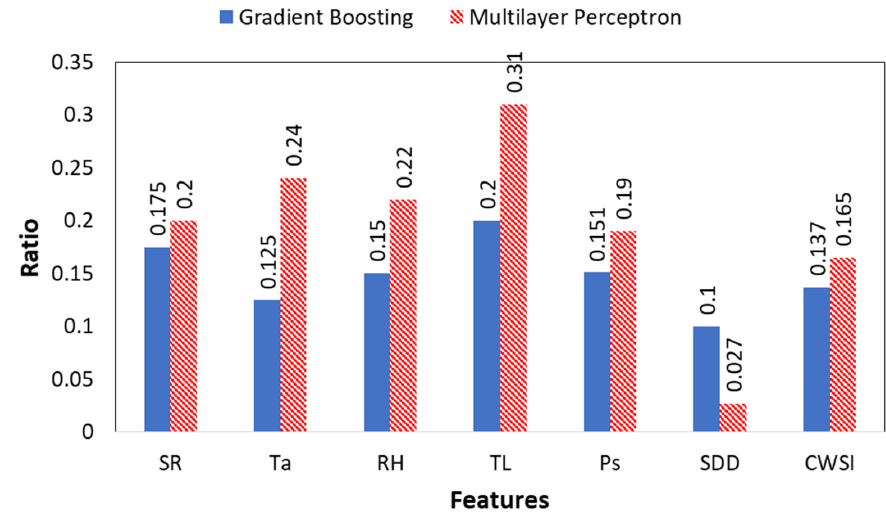
Figure 7. Feature importance of the measured factors in the set ‐ up of GB and MLP algorithm during RUN 1.